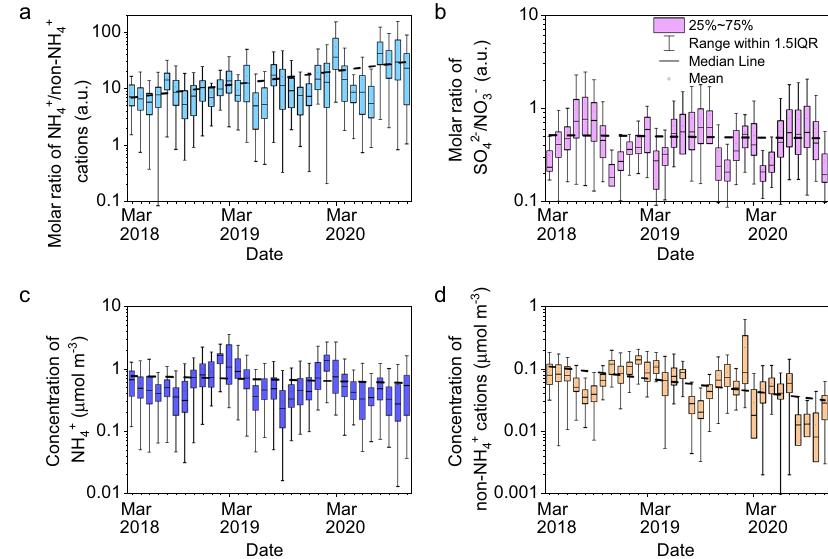
Fig. 4 | The variations of NH 4 + , non-NH 4 + cations, SO 4 2 − and NO 3 − . a , b The monthly mean values of the ratios of NH 4 + /other cations and SO 4 2 − /NO 3 − ; c , b the mass concentrations of NH 4 + and other cations in Shijiazhuang. The dashed lines are a linear fi t of the monthly mean